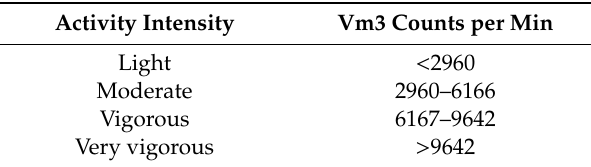
Table 1. Freedson 3 VM3 count cutpoints